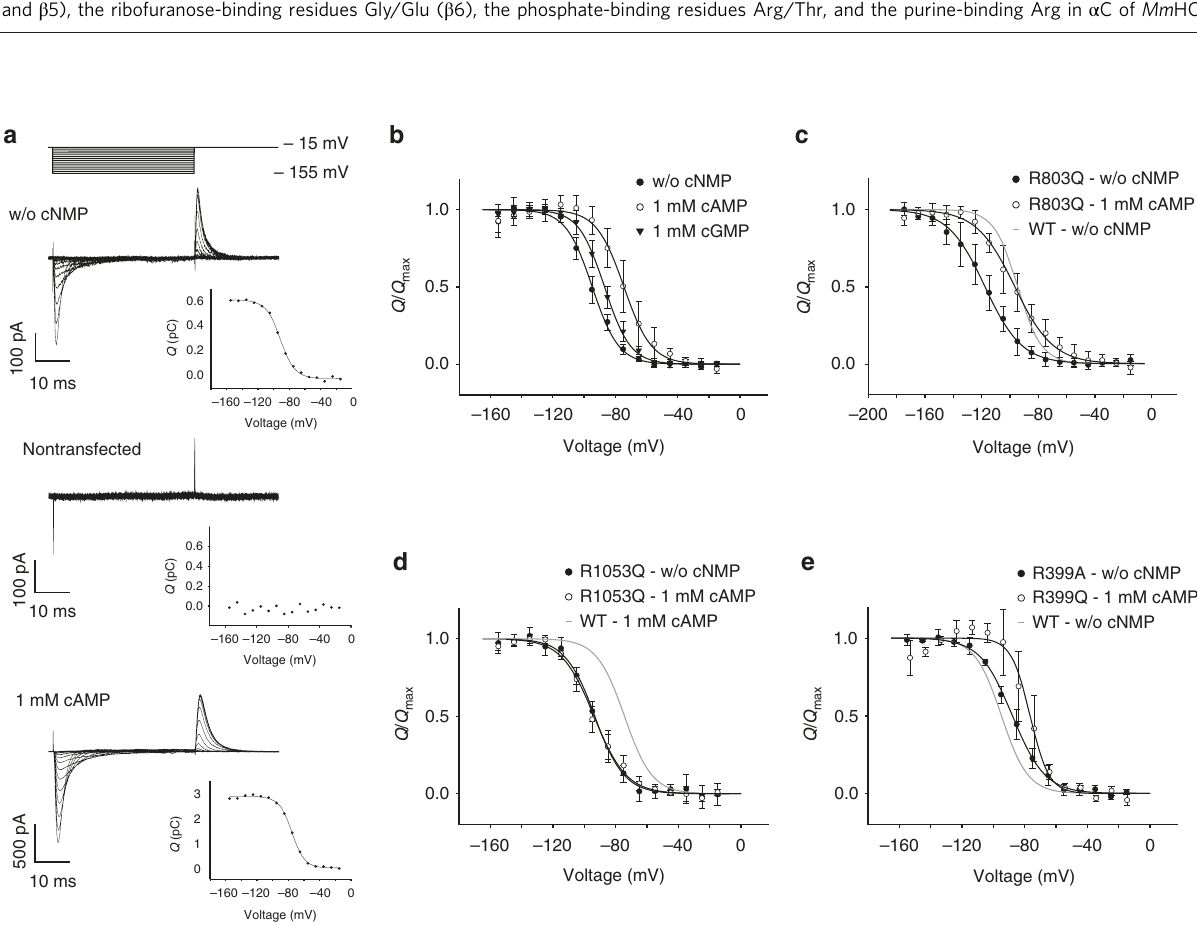
Fig. 1 Structural features of Sp SLC9C1. a Transmembrane topology of Escherichia coli NhaA ( Ec NhaA), Methanocaldococcus jannaschii NhaP1 ( Mj NhaP1), and sea urchin Strongylocentrotus purpuratus SLC9C1 ( Sp SLC9C1); VSD voltage-sensing domain, CNBD cyclic nucleotide-binding domain. Amino acids that may participate in Na + coordination are highlighted (black dots). Asterisks indicate conserved Arg residues that are relevant for Na + /H + antiport; Arg320 and Arg347 in Mj NhaP1; Arg399 and Arg431 in Sp SLC9C1. An Arg is substituted by Lys300 in Ec NhaA. b Scheme of the trigonal bi-pyramidal structure of the Na + coordination site from Mj NhaP1. Numbers refer to the respective amino-acid residues in E. coli (blue), M. jannaschii (red), and S. purpuratus (black). c Sequence comparison of the VSD from several SLC9C1 members with the canonical VSD of Drosophila Shaker K + channel ( Dm Shaker) and Ciona intestinalis voltage-sensor-containing-phosphatase ( Ci VSP). S. purpuratus ( Sp SLC9C1), H. sapiens ( Hs SLC9C1), M. musculus ( Mm SLC9C1), C. intestinalis ( Ci SLC9C1), and spotted gar L. oculatus ( Lo SLC9C1). Voltage sensors carry conserved positively charged residues in S4 (blue) and conserved negatively charged amino acids in S1 – S3 (red). d Cyclic nucleotide-binding domains from sea urchin ( Sp SLC9C1), human ( Hs SLC9C1) and mouse ( Mm